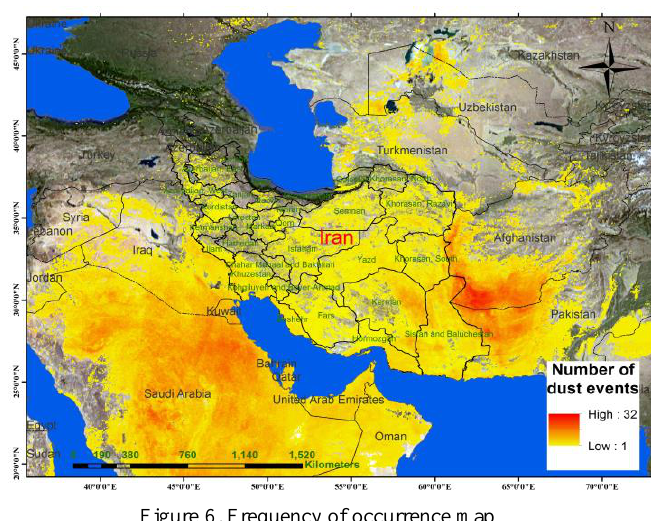
Figure 6. Frequency of occurrence map of dust storms in 1397 Hijri